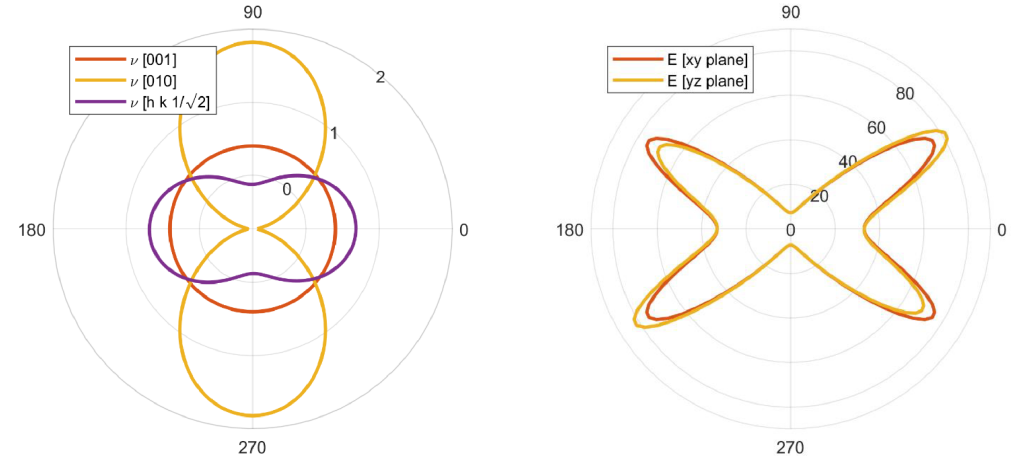
Figure A5. Benchmarks to Gunton and Saunders (1972, their Figs. 3 and 6) for trigonal arsenic.